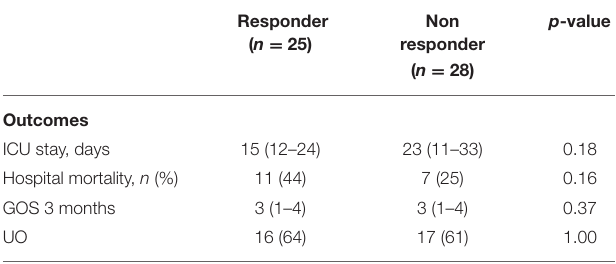
TABLE 3 | Characteristics of population according to PbtO 2 responder or non-responder to CPP